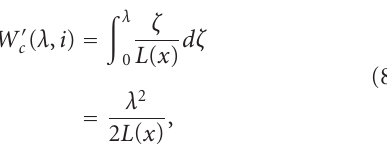
coenergy in the magnetic energy-conversion system can be expressed as